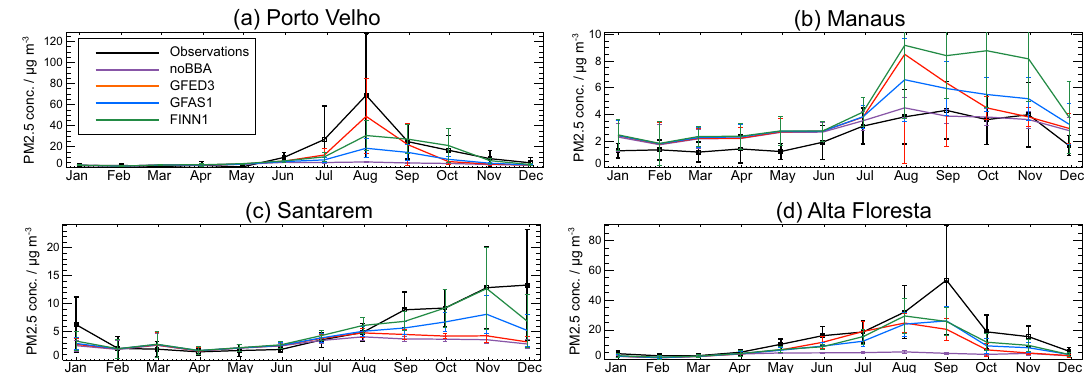
Figure 4. Average seasonal cycles in observed (black) and simulated (colour) multi-annual monthly mean PM 2 . 5 concentrations at four ground stations in the Amazon region: (a) Porto Velho (2009–2011), (b) Manaus (2008–2011), (c) Santarem (2003–2006), and (d) Alta Floresta (2003–2004). Multi-annual monthly mean concentrations were calculated by averaging over all years of available observation data between January 2003 and December 2011. The modelled results are shown for four simulations: without biomass burning (purple), with GFED3 emissions (red), with GFAS1 emissions (blue) and with FINN1 emissions (green). The error bars show the standard deviation of the mean of the observed and simulated values, which represents the inter-annual and intra-monthly variability in the daily mean PM 2 . 5